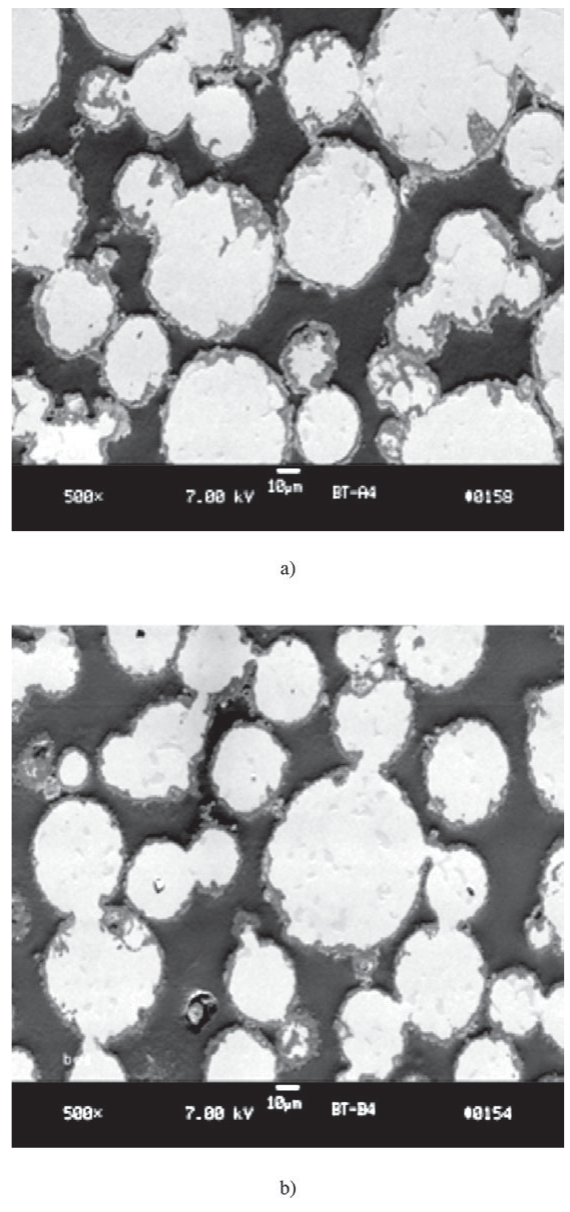
Figure 8. SEM micrographs of a) “as cast”; b) “pre-oxidized” Ni- Cr-2 × Al-Fe sintered powder after corrosion testing for 1,000 h at 850